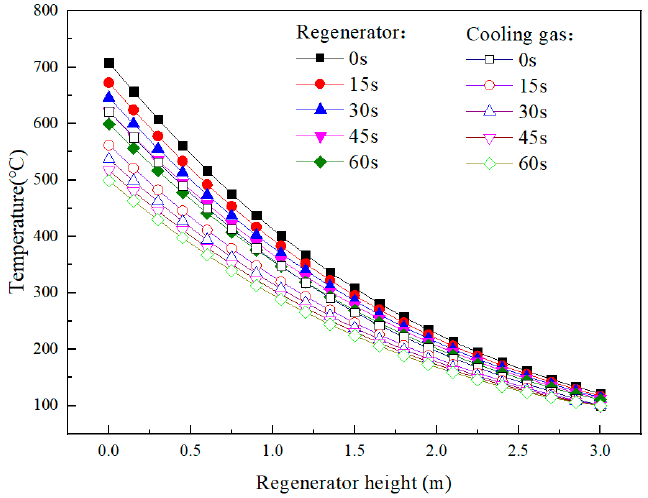
Figure 9. Temperature of cooling gas and heat storage materials during cooling period.